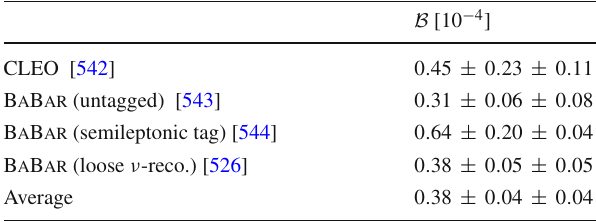
Table 87 Summary of exclusive determinations of B + → η(cid:12) + ν . The errors quoted correspond to statistical and systematic uncertainties, respectively